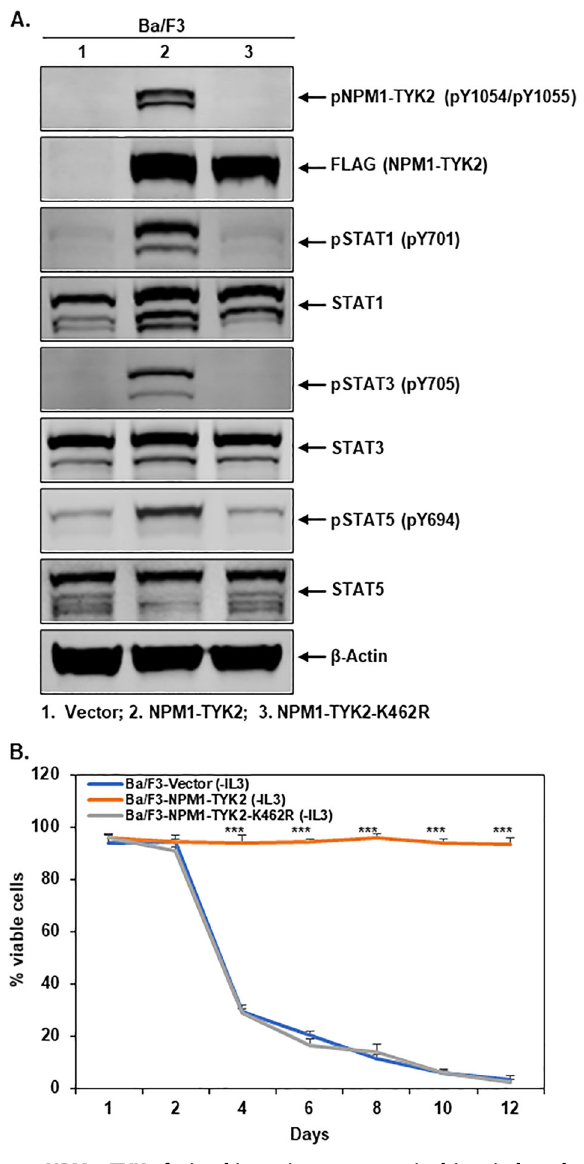
Fig. 3 NPM1 – TYK2 fusion kinase is an oncogenic driver in lymphoid cell transformation. A Fusion kinase-dead mutant blocks kinase activation and downstream signaling. Cell lysates were made from Ba/F3-vector, Ba/F3 – NPM1 – TYK2, and Ba/F3 – NPM1 – TYK2 – K462R cell lines, and immunoblot analysis was performed for FLAG (NPM1 – TYK2), phospho-NPM1 – TYK2, phospho-STAT1/3/5, and respective total proteins. β -Actin served as an internal control. B Fusion kinase signaling drives cell transformation. Ba/F3-Vector, Ba/ F3 – NPM1 – TYK2, and Ba/F3 – NPM1 – TYK2 – K462R cells were grown in RPMI medium in the absence of IL-3. Cell viability from